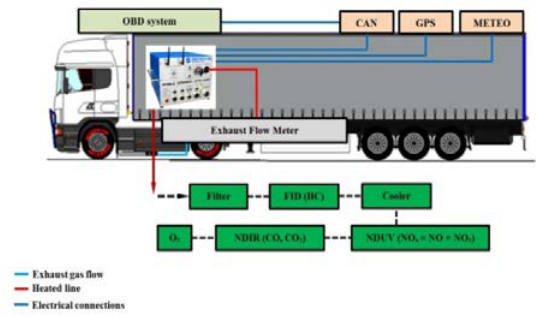
Fig. 3. The Semtech DS work